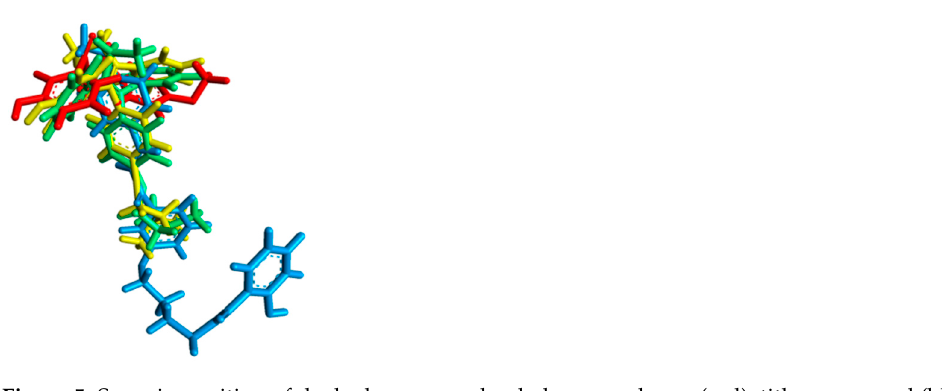
Figure 4. The binding modes of title compound to ER α using Discovery Studio 2020 Client, ( a ) 3D visualization, and ( b ) 2D visualization.